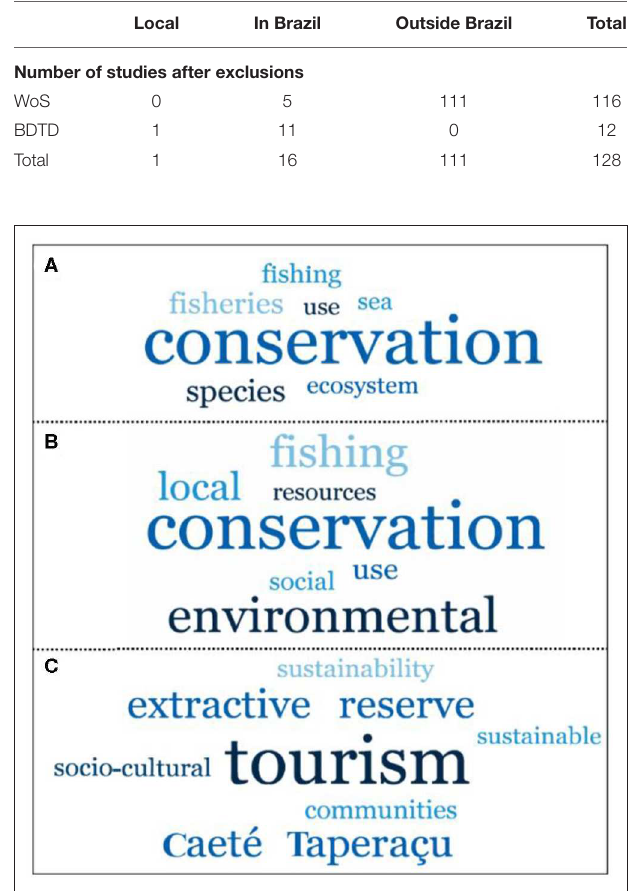
TABLE 3 | Studies selected.